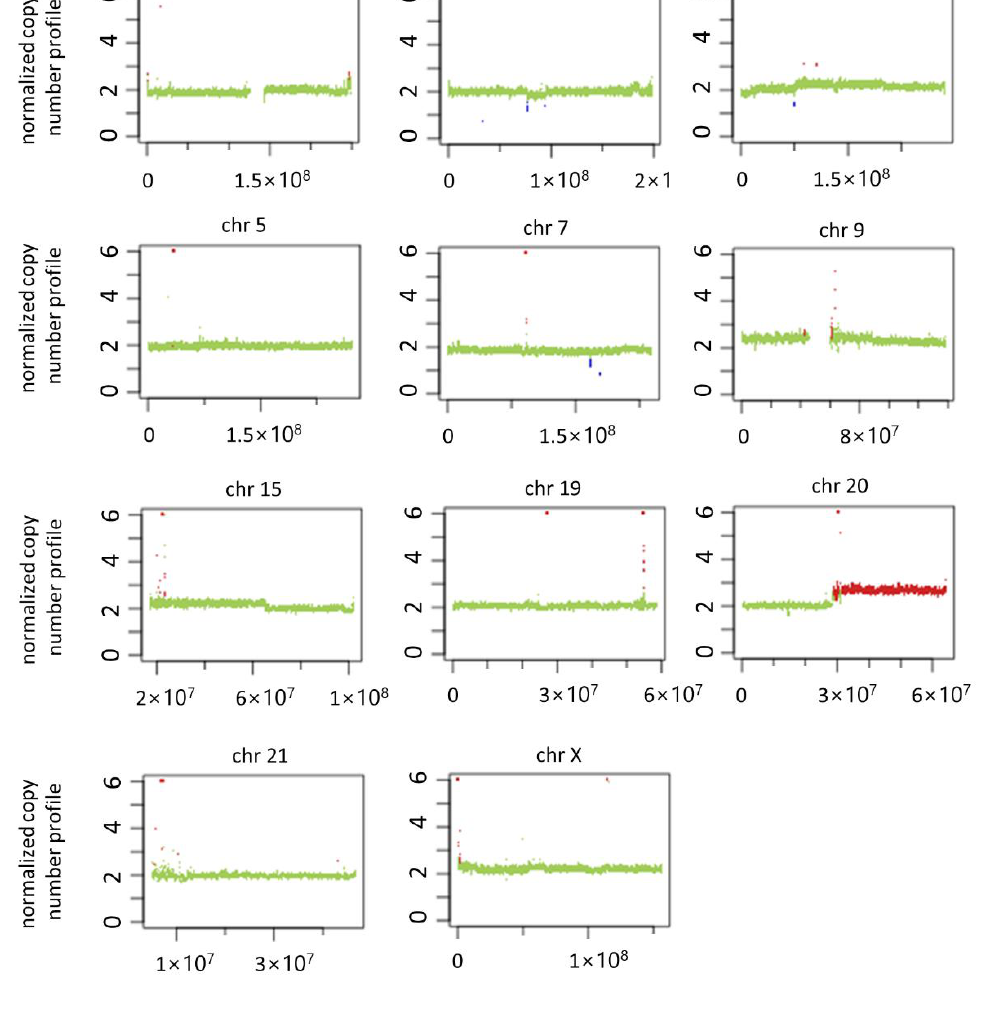
Figure 6. These graphs summarize the results of the chromosomal gain or loss events of HEK293T cells, treated with plasma from patients, compared to cells treated with plasma from healthy subjects. An image is shown for each chromosome where we found statistically significant results (other chromosomes in Supplementary Figure S3). The chromosomal position is shown on the abscissa axis. The number of copies of each specific chromosomal segment is shown in the ordinate axis. In the absence of CNV events, values equal to 2 (diploidy) are expected. Unfortunately, the size of this image does not allow for a good appreciation of the CNV events, so we have included the high-magnification image (Supplementary Figure S4), and more details are shown in Table 2.